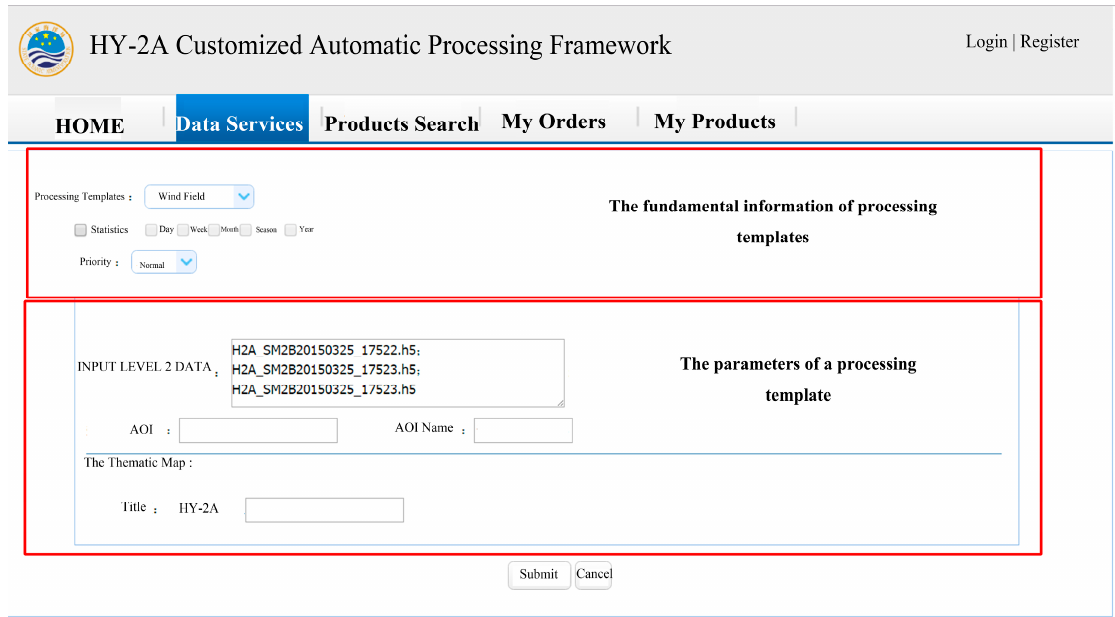
Figure 4. The GUI of the product order module for a customized wind field processing workflow.